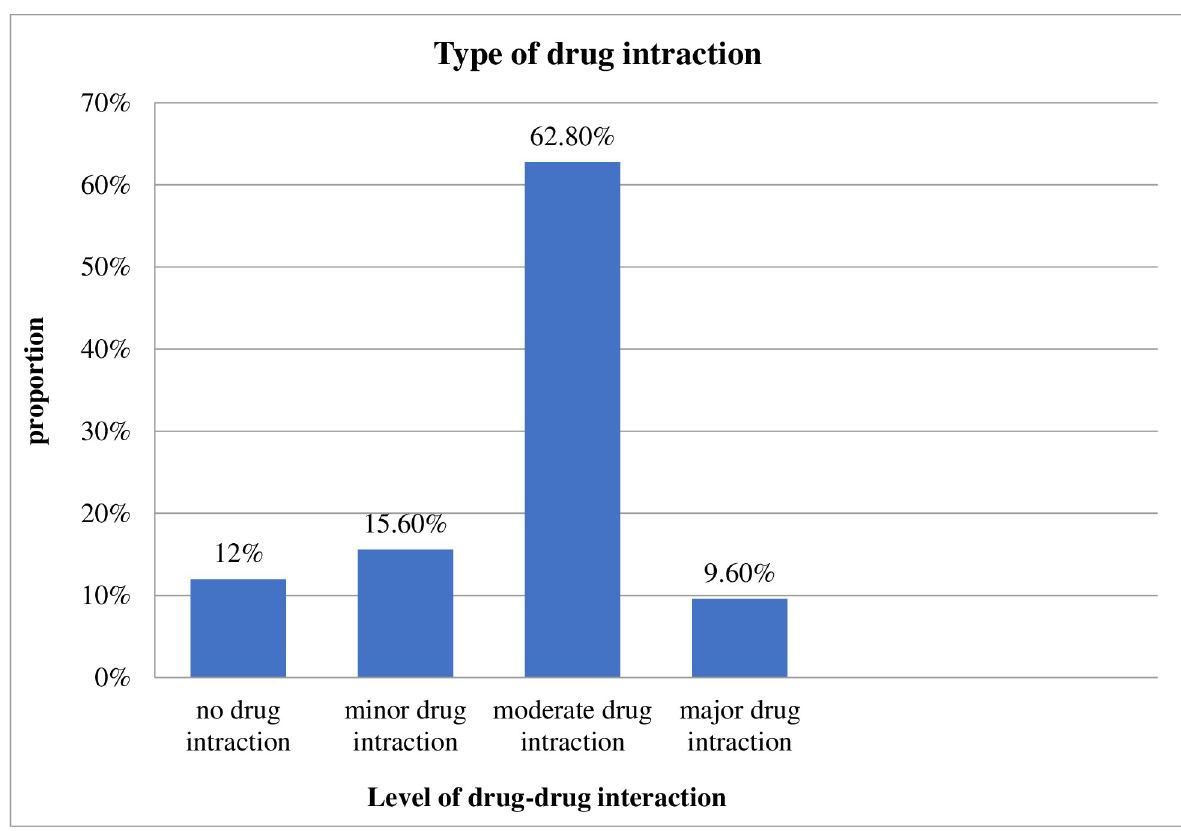
Fig 2. The level of drug-drug interactions in the study